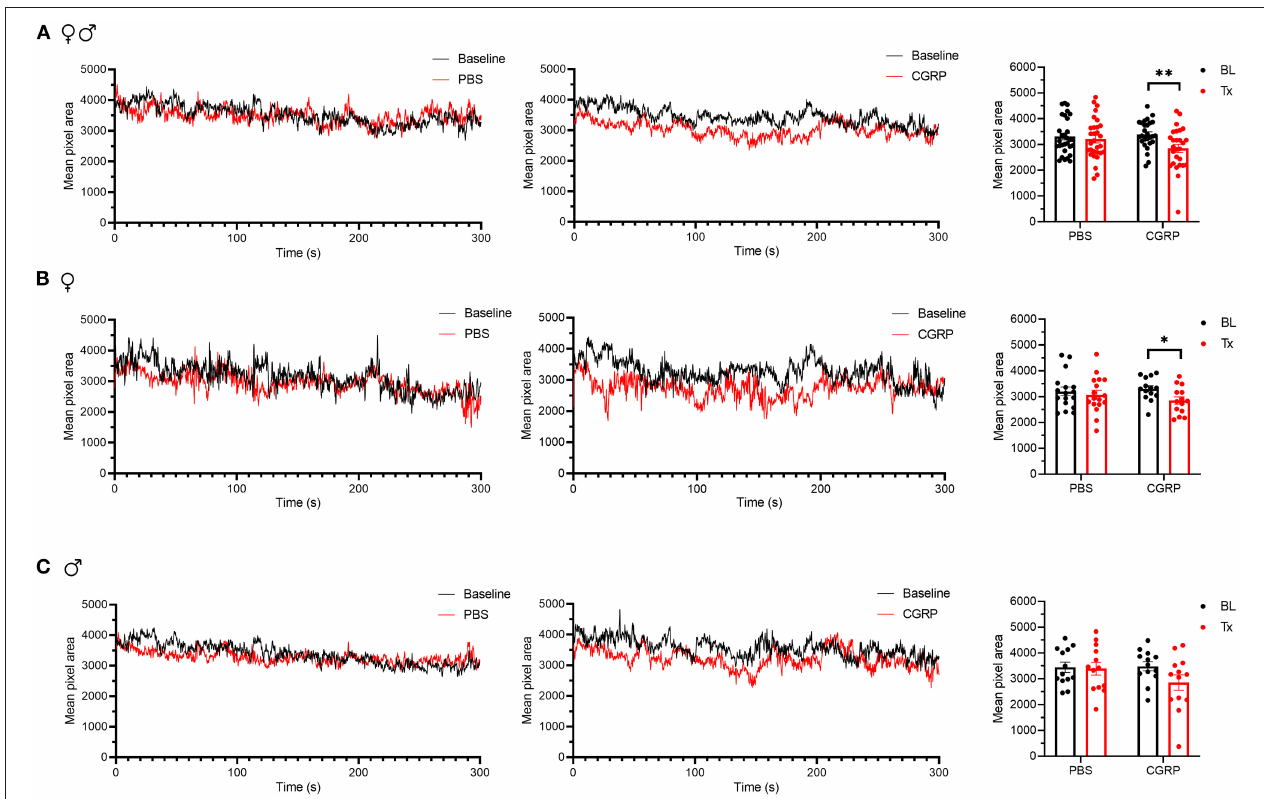
FIGURE 6 | Injection of CGRP into the MN induced nociceptive squinting behavior. (A) Mean pixel area over 5-min testing period for all mice without treatment (as baseline), with injection of PBS (left) or CGRP (middle; 1 µ g/200 nl) into the right MN of C57BL/6J mice via cannulas. Right panel is the mean pixel area over 5-min testing period for individual mice (PBS: n = 30; CGRP: n = 27). Data from A separated as female (B) and male (C). Data are from two independent experiments and one crossover treatment experiment. (B) Mean pixel area over 5-min testing period for female mice (left and middle) and mean pixel area over 5-min testing period for individual female mice (right; PBS: n = 17; CGRP: n = 14). (C) Mean pixel area over 5-min testing period for male mice (left and middle) and mean pixel area over 5-min testing period for individual male mice (right; PBS: n = 13; CGRP: n = 13). Data are the mean ± SEM. Statistics are described in Supplementary Table 1 . * p ≤ 0.05, ** p ≤